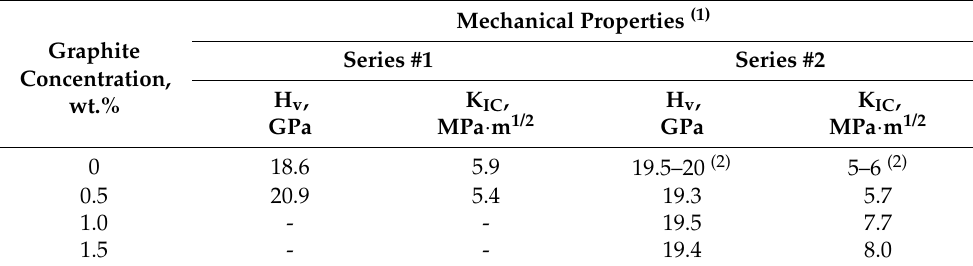
Mechanical Properties